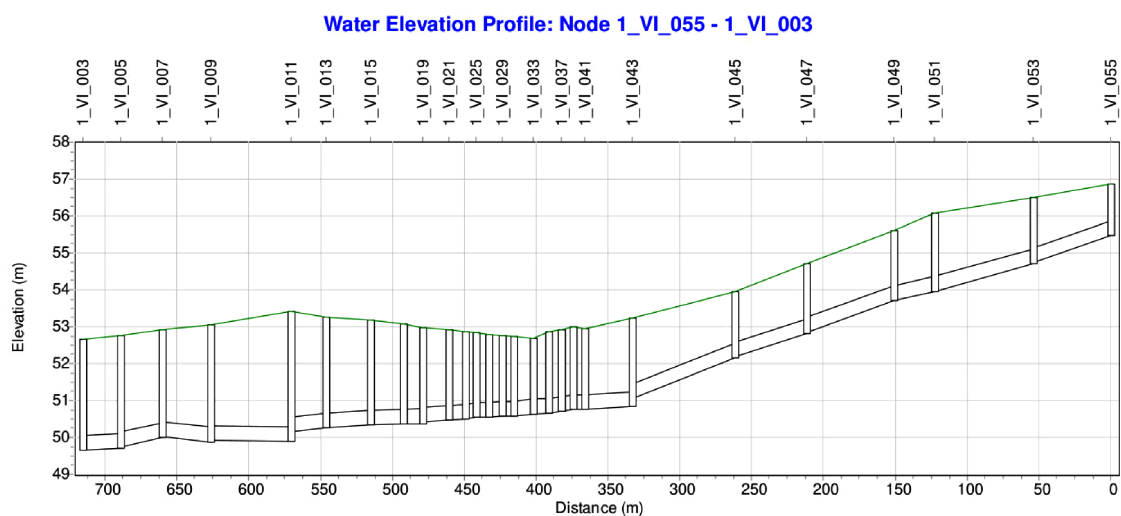
Figure 3. Profile of channel VI in Szarych